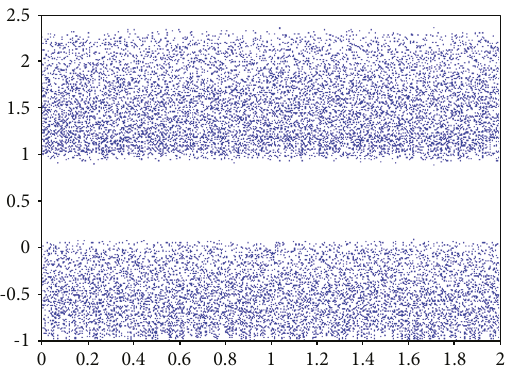
Figure 11: Bifurcation diagram by adjusting α from 0 to 2.